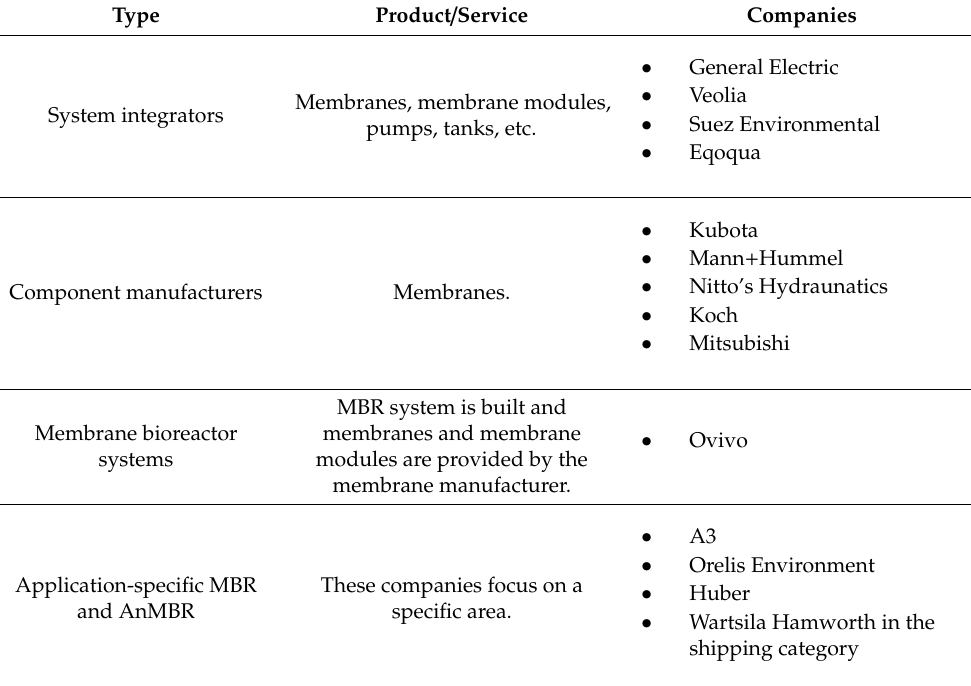
Table 5. Various MBR manufacturing industries and their products and